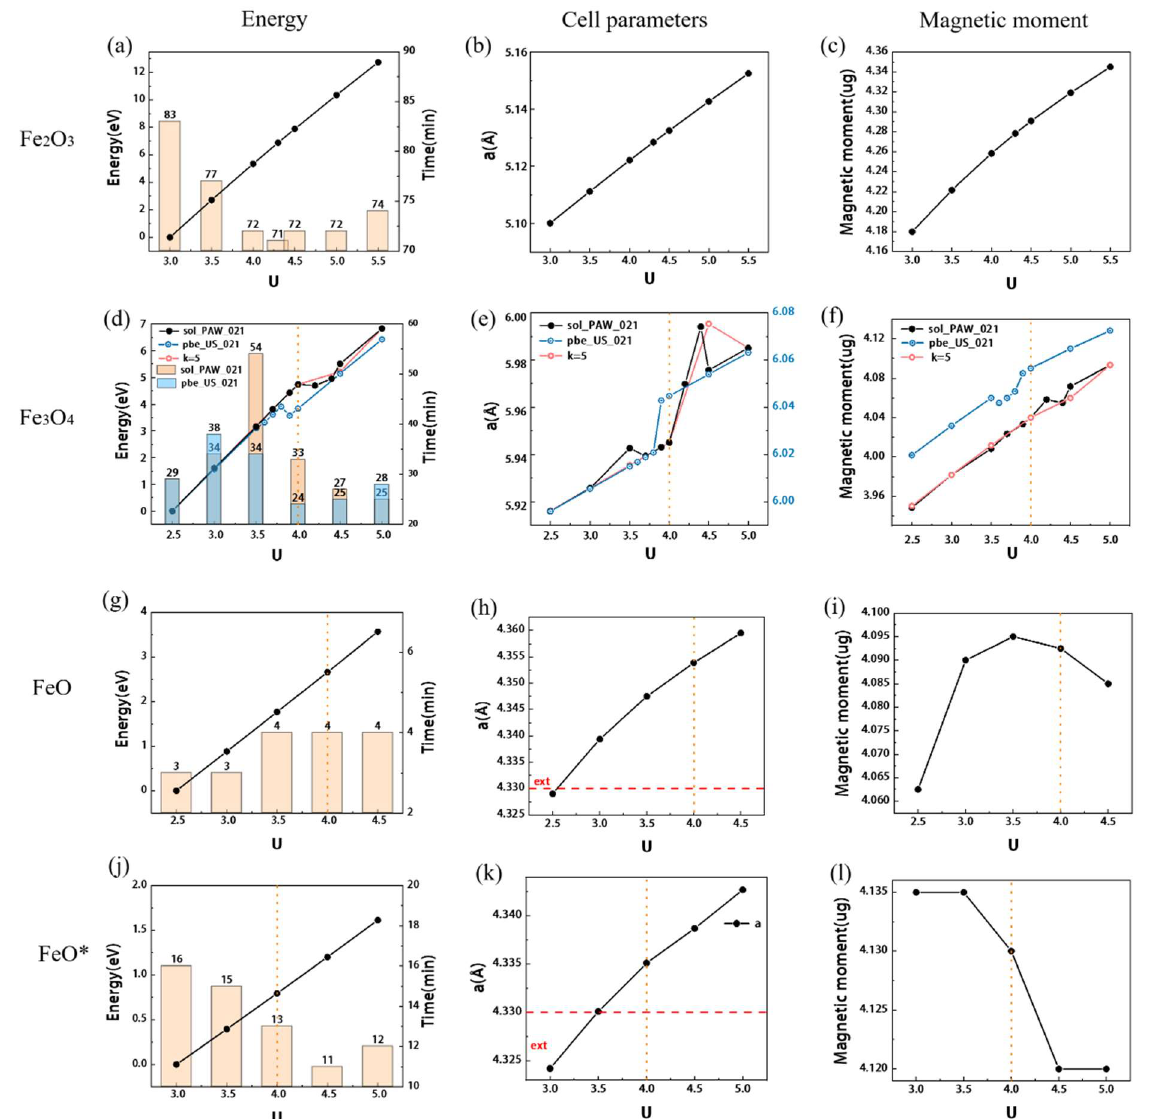
Figure 5. The test results for three iron oxides U, the horizontal direction is the parameters of the same oxide (( a – c ) for Fe 2 O 3 , ( d – f ) for Fe 3 O 4 , ( g – i ) for FeO, ( j – l ) for FeO *), and the vertical direction is the comparison of the same results. The histogram is the calculation time, the orange dotted line is the position of the final value, and the red line is the experimental value.